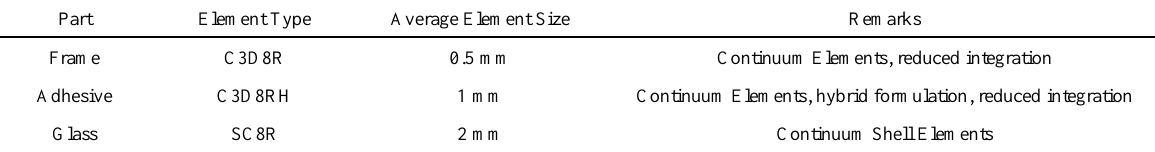
Table 2: Used Element Types and Sizes for the Global Model (ref. to (Dassault Systemes Simulia Corp. 2016))